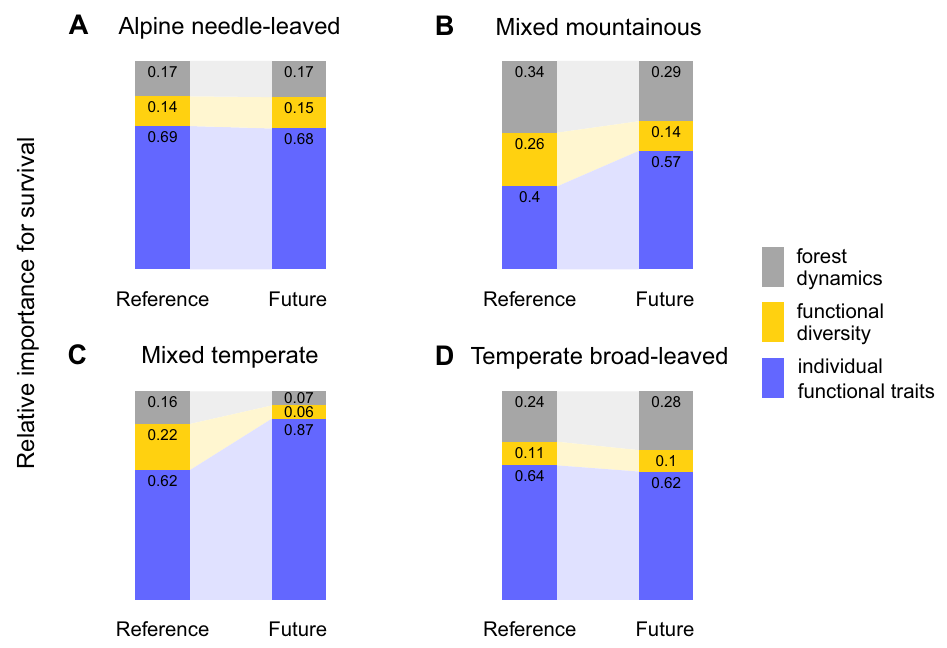
Figure 2. Relative importance of functional diversity, forest dynamics and individual traits for individual tree survival under reference climate and future climate conditions (RCP 4.5). Panels correspond to alpine needle- leaved ( A ), mixed mountainous ( B ), mixed temperate ( C ) and temperate broad-leaved ( D ) forests. Left bars in each panel illustrate reference climate (no warming) and right bars future climate (RCP4.5). Colours indicate forest dynamics (grey), functional diversity (yellow) and individual functional traits (blue). Forest dynamics include the number of locally competing trees (> 5 m in height) and local biomass as a proxy for the successional